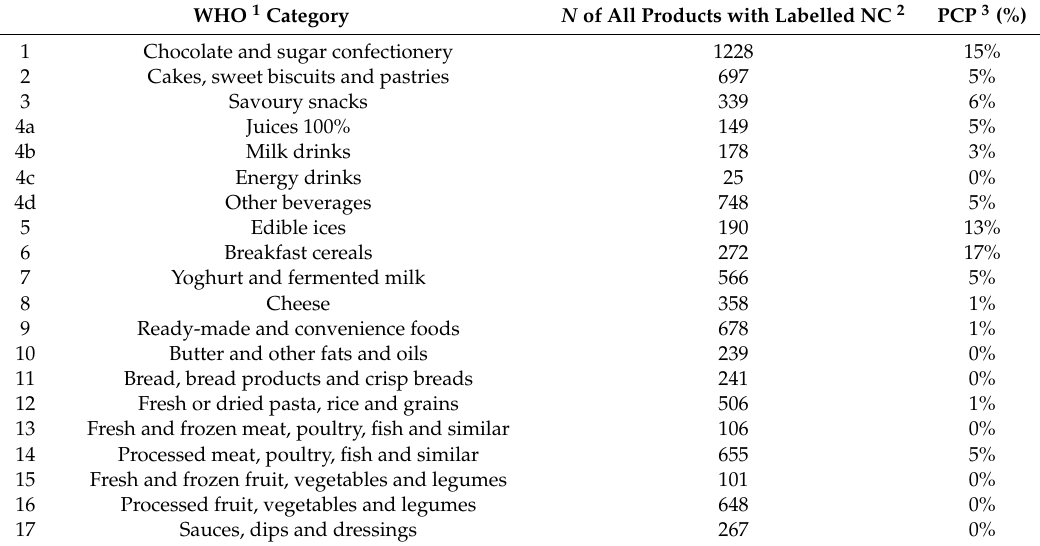
Table 1. Number of products with labelled nutritional compositions and proportion of products with child-targeted